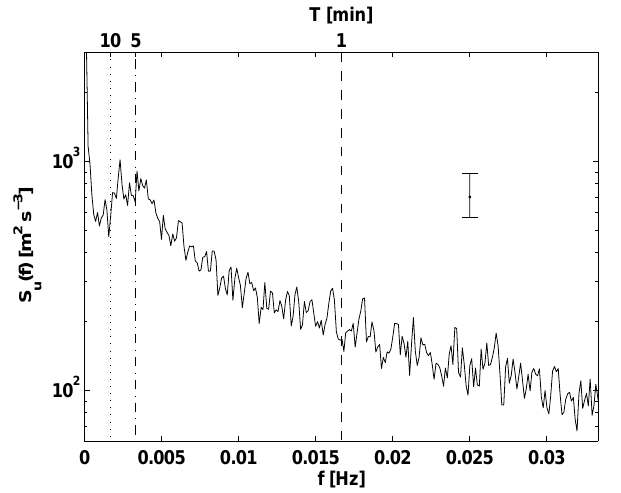
Fig. 5. A lin-log representation of the mean power spectrum of the streamwise velocity component (solid curve) for the entire bora episode. The vertical lines denote the periods of 10min (dotted line), 5min (dashed-dotted line) and 1min (dashed line). Vertical error bar shows the 95% confidence interval.